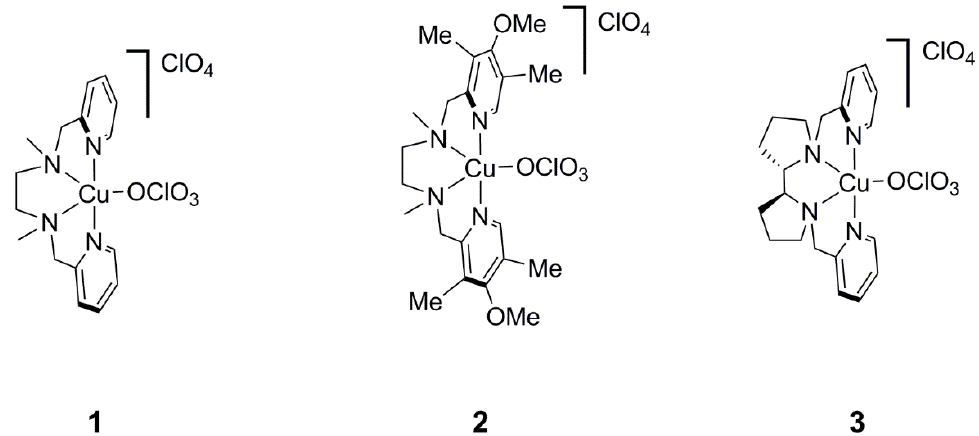
Figure 2. Synthesized copper complexes 1 – 3 with the bispicen (N2/Py2) ligand system.